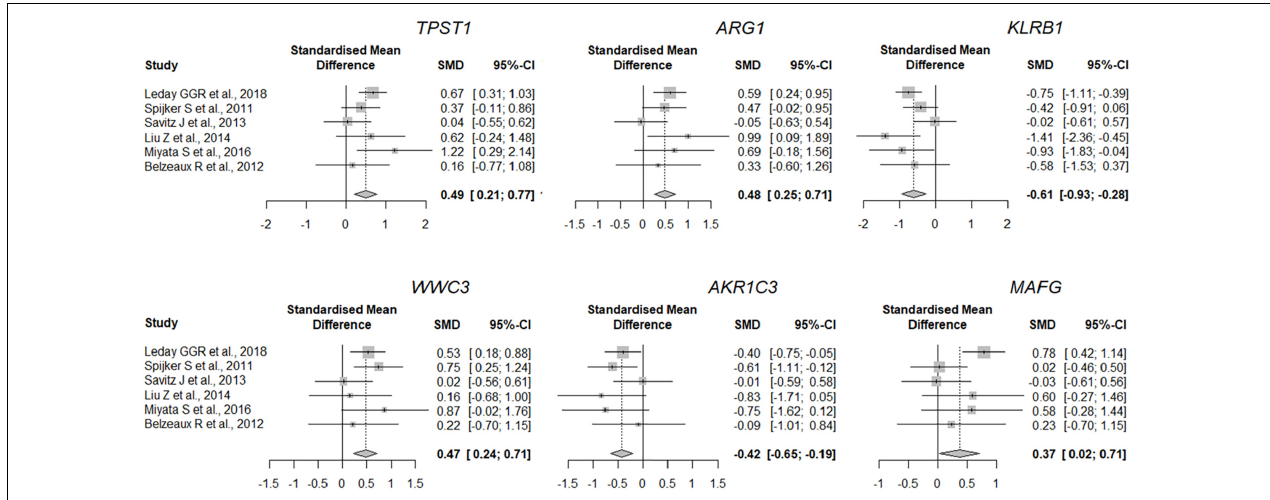
FIGURE 3 | Expression of most significant DEGs between MDD and control group (a random-effects model) in different studies. Lines indicate 95% confidence intervals (CI), and the midpoint of each line is denoted by a square indicating the standardized mean difference (SMD) for each study. Diamond indicates overall SMD and 95% confidence interval.